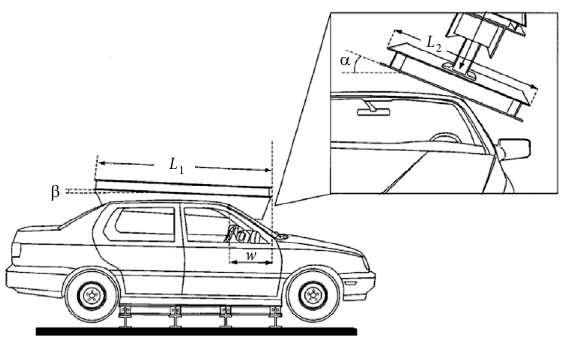
Fig. 2. Static roof crush testing (Mohan et al.